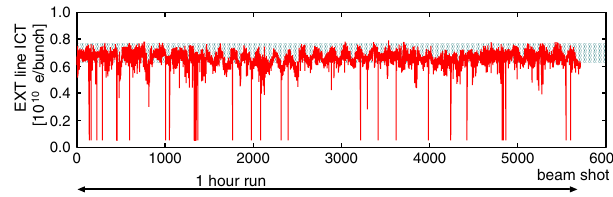
FIG. 15. (Color) Trend of beam intensity during a 1-hour run. Approximately 60% of the data survived the intensity cut.